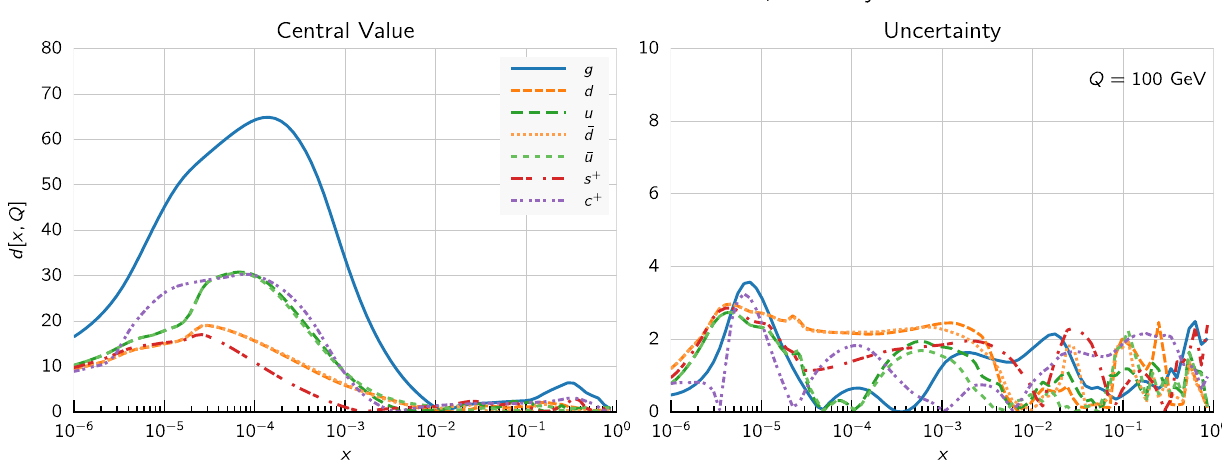
Fig. 10 The statistical distances between the central values (left) and the PDF uncertainties (right plot) of the NNPDF3.1sx NNLO and NNLO+NLL x fits at Q = 100 GeV in the flavor basis